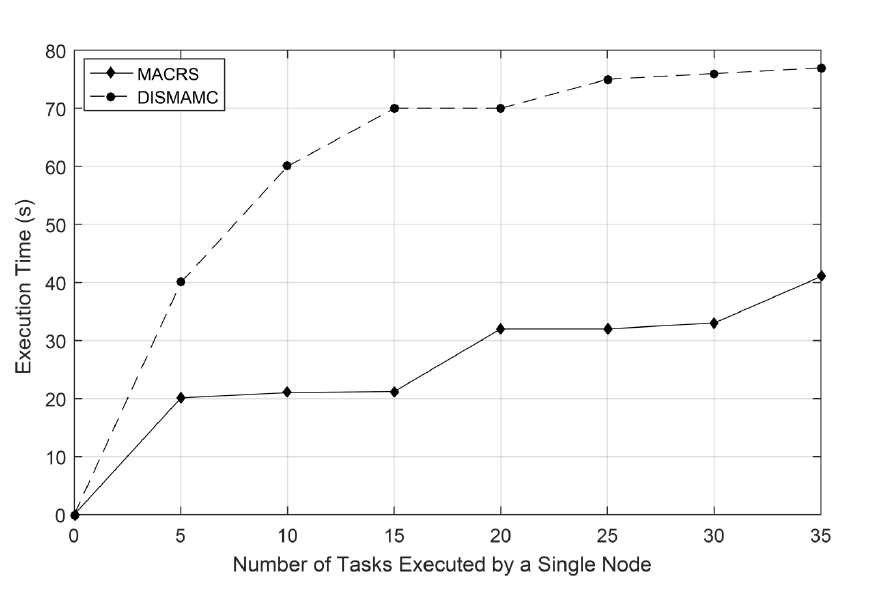
Figure 17. Overall execution time for different